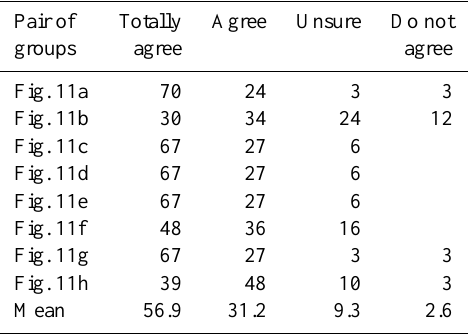
Table 5. Statistical results of the psychological test